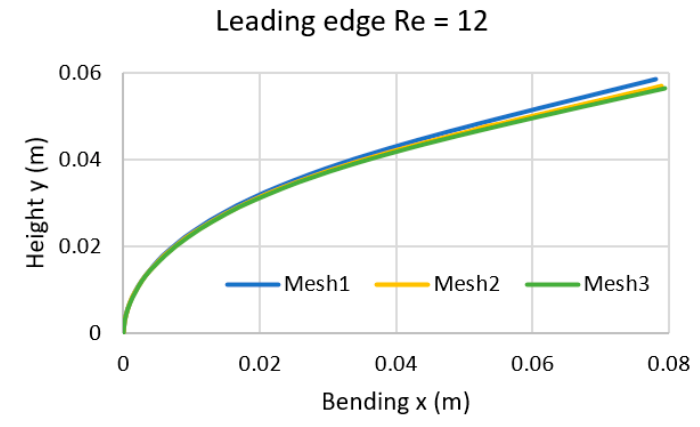
Figure 3. Bending line comparison of different mesh resolutions at Re = 12.